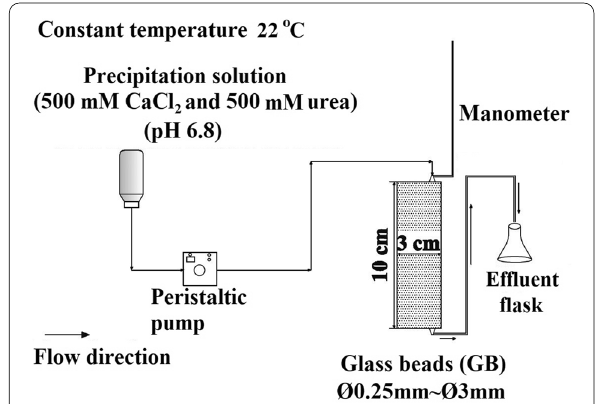
Fig. 1 Experimental setup revised from Eryürük et al.